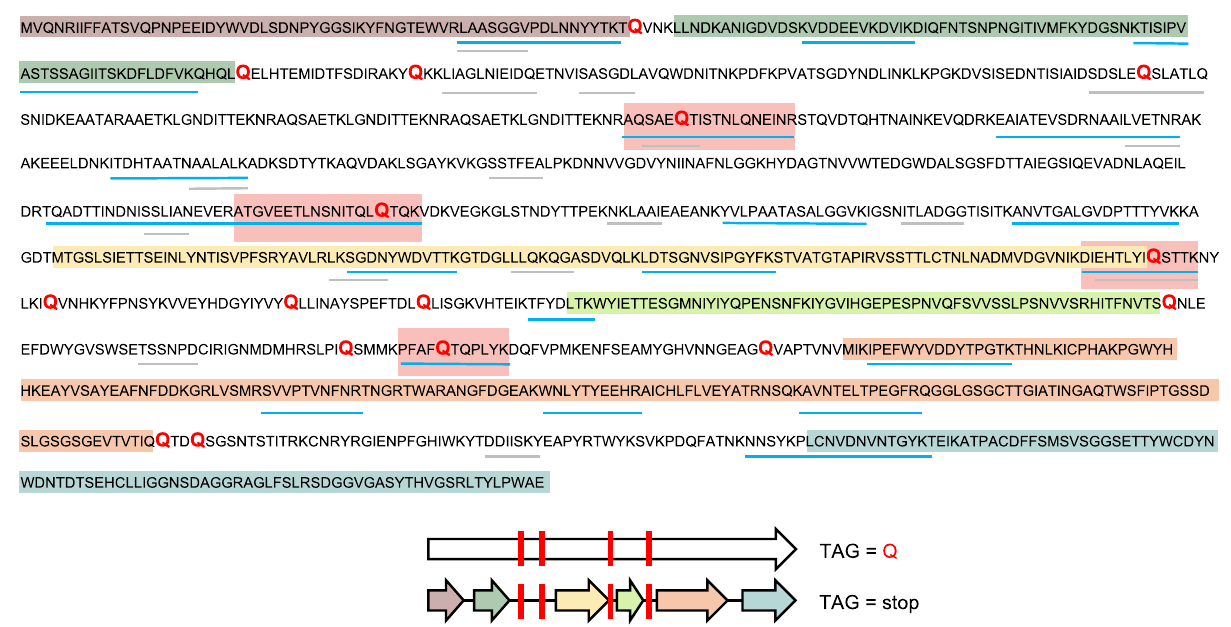
of the predicted protein sequence with matching de novo sequence tag coverage. Red text in the sequence indicates the location of glutamine residues from reas- signed stop codons. Red boxes on the sequence coverage map and red bars on graphical representation indicate the recoded glutamine residues with peptides identi fi ed through database searching.